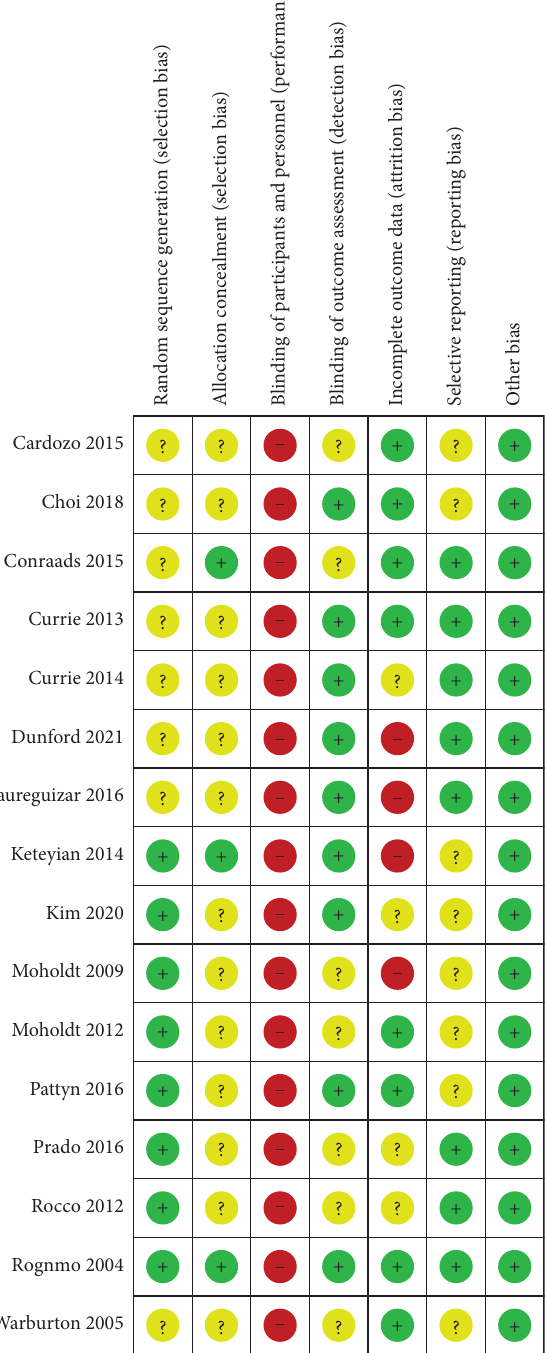
Figure 2: Risk of bias